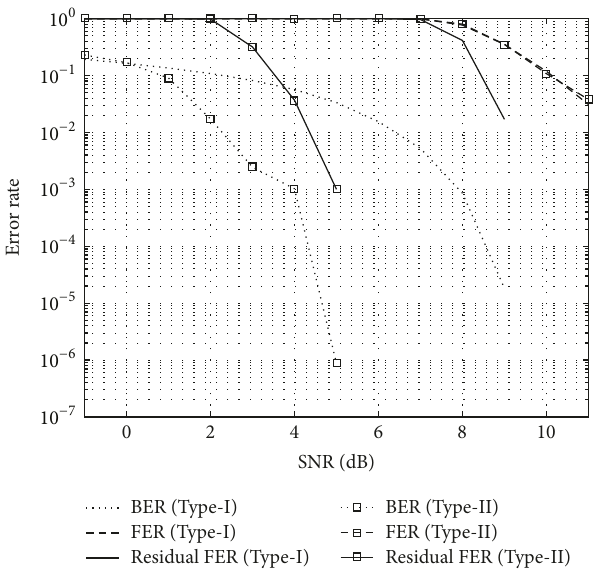
Figure 17: FER performance of Type-I and Type-II schemes. Note that the FER of Type-I and Type-II overlap as expected.